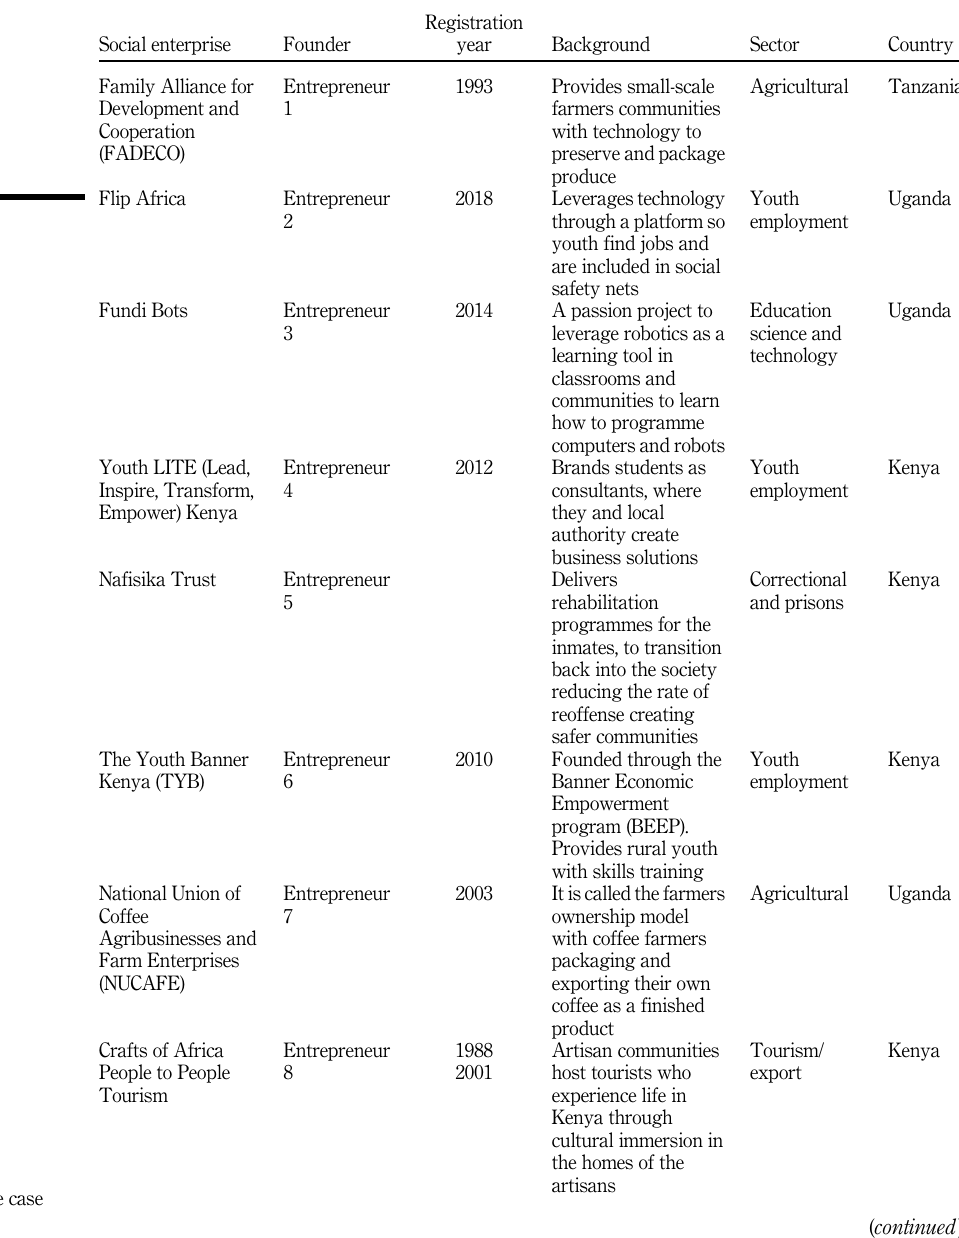
Table 1. Profile of the case